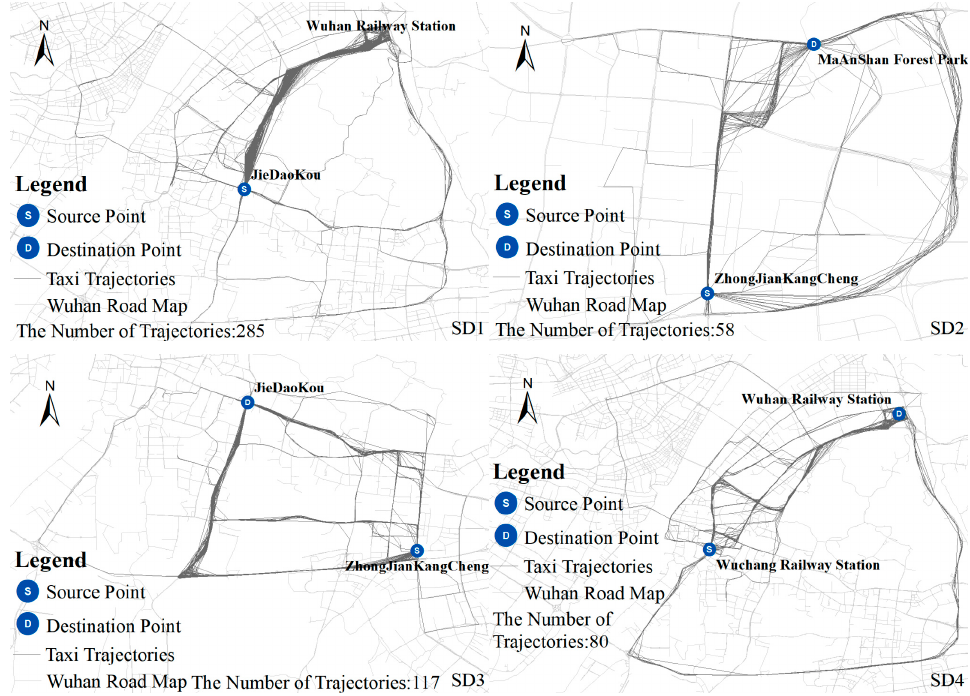
Figure 3. Geographic distribution of four SD pairs of experimental data.